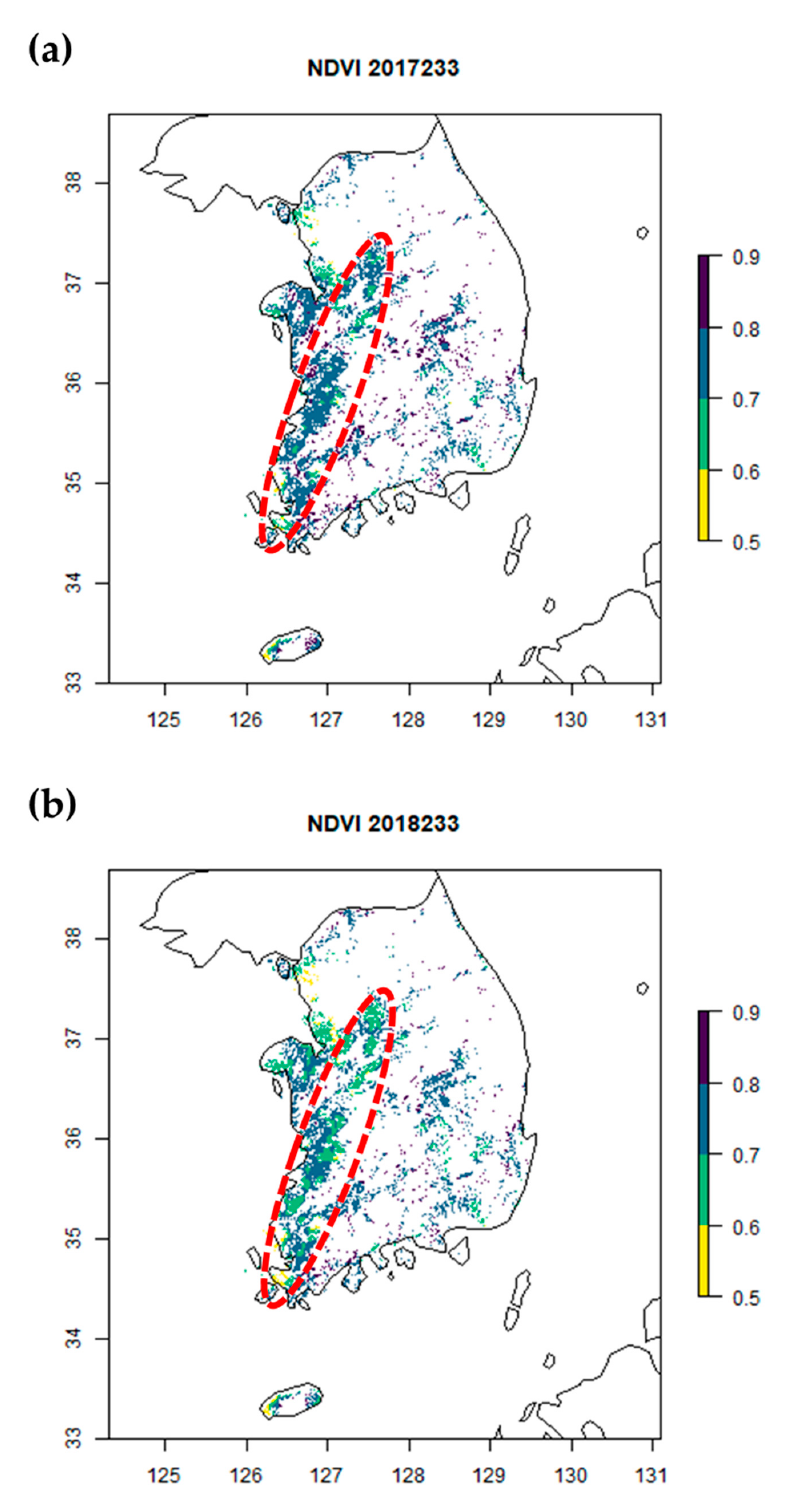
Figure 13. Maps of NDVI in the croplands in South Korea for August 21–28 of 2017 ( a ) and 2018 ( b ). The NDVI in 2018 was lower than in 2017 due to a heatwave, low rainfall, decreased soil moisture and increased ET 0 . The red dashed line denotes the major agricultural areas in South Korea.